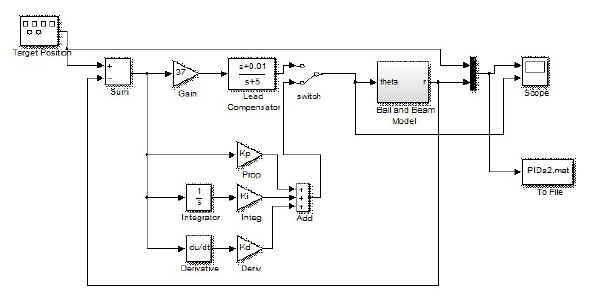
Figure 4: Matlab Simulink PID controller.